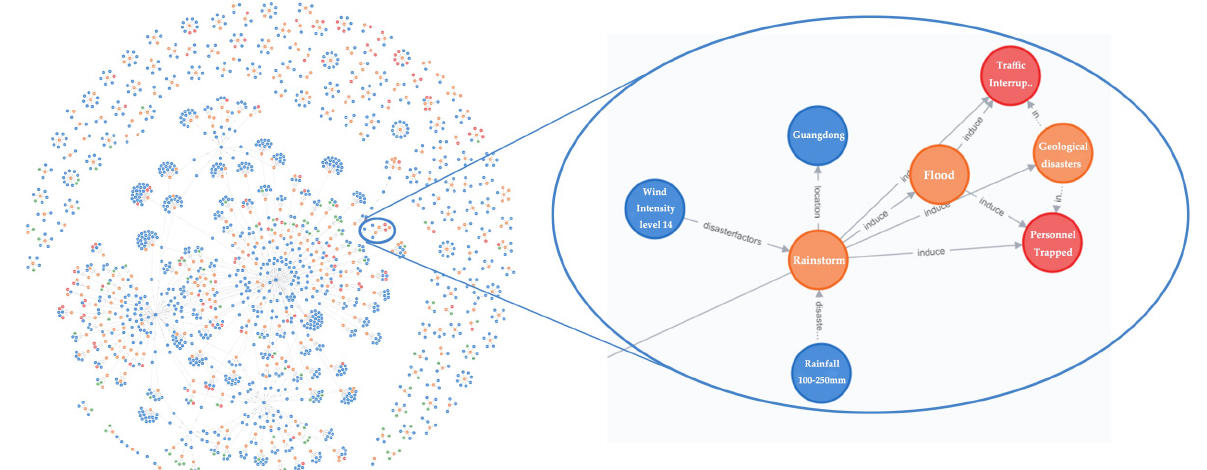
Figure 10. Part of the typhoon event graph in Neo4j database (In en-US).